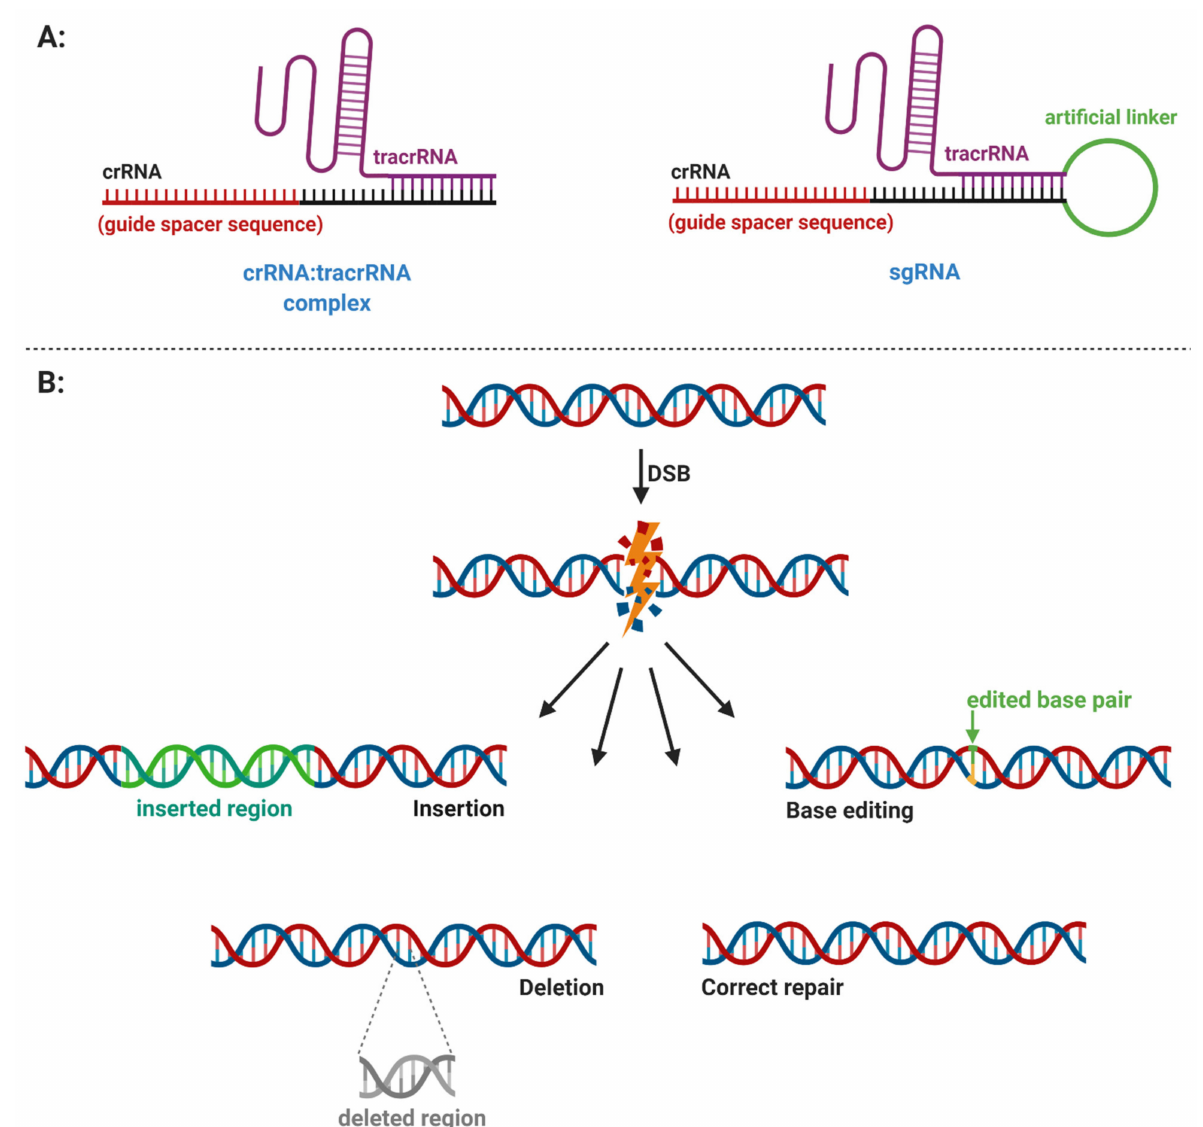
Figure 6. ( A ) General structure of the CRISPR RNA (crRNA)–trans-activating CRISPR RNA (tracrRNA) complex and artificial single-guide RNA (sgRNA). ( B ) CRISPR–Cas-assisted gene editing. The figure was created with BioRender.com (accessed on 15 February